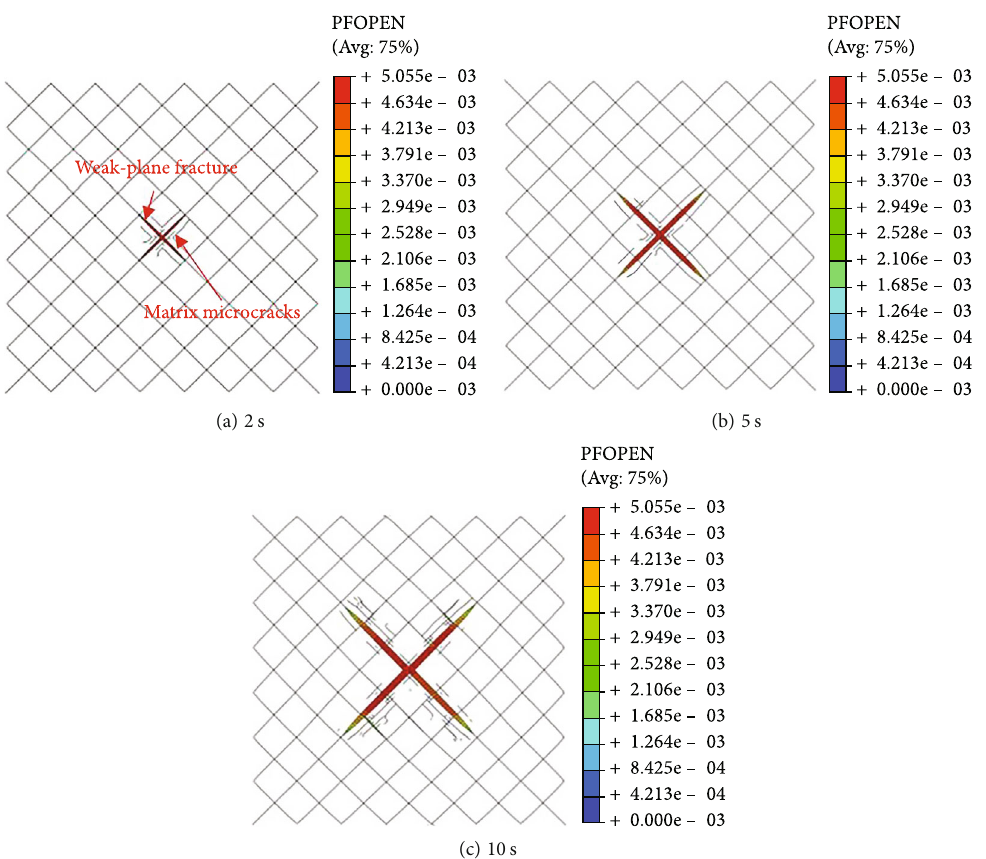
Figure 7: Opening distribution of weak plane type and matrix type fractures based on model